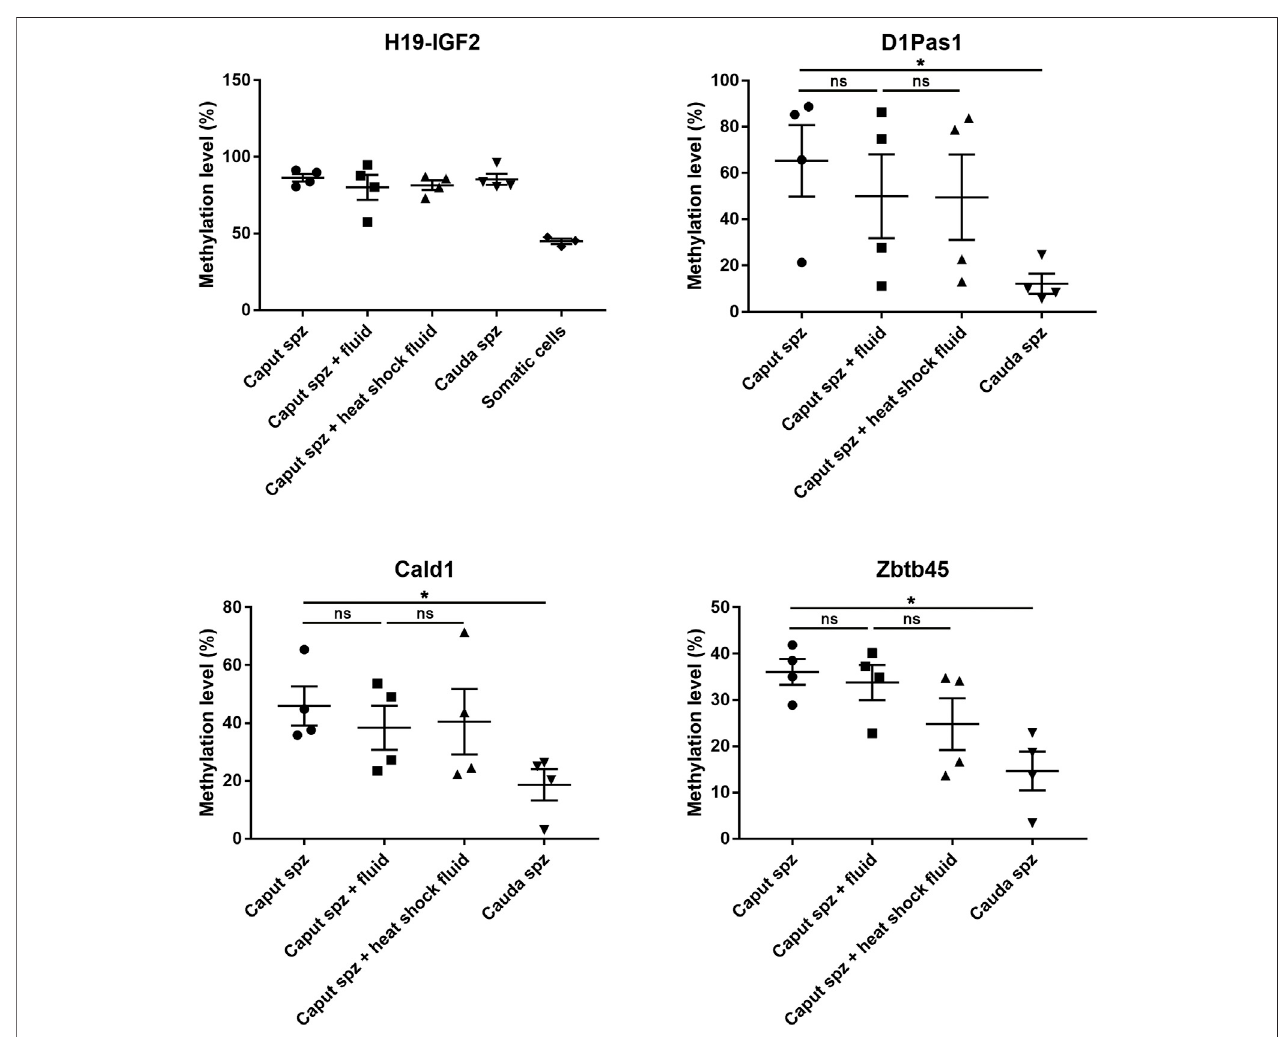
FIGURE9| Effect ofepididymal fl uidonsperm methylationpro fi ling.Followingincubation of caput spermatozoawith cauda epididymal fl uidorenzyme-inactivated fl uid (heat shock), DNA loci that exhibited signi fi cant methylation changes during post-testicular maturation were analyzed by pyrosequencing. For each locus, four samples of testicular, caput , corpus , and cauda spermatozoa were used. H19-IGF2 served to validate the absence of somatic cell contamination. * p -value < 0.05.